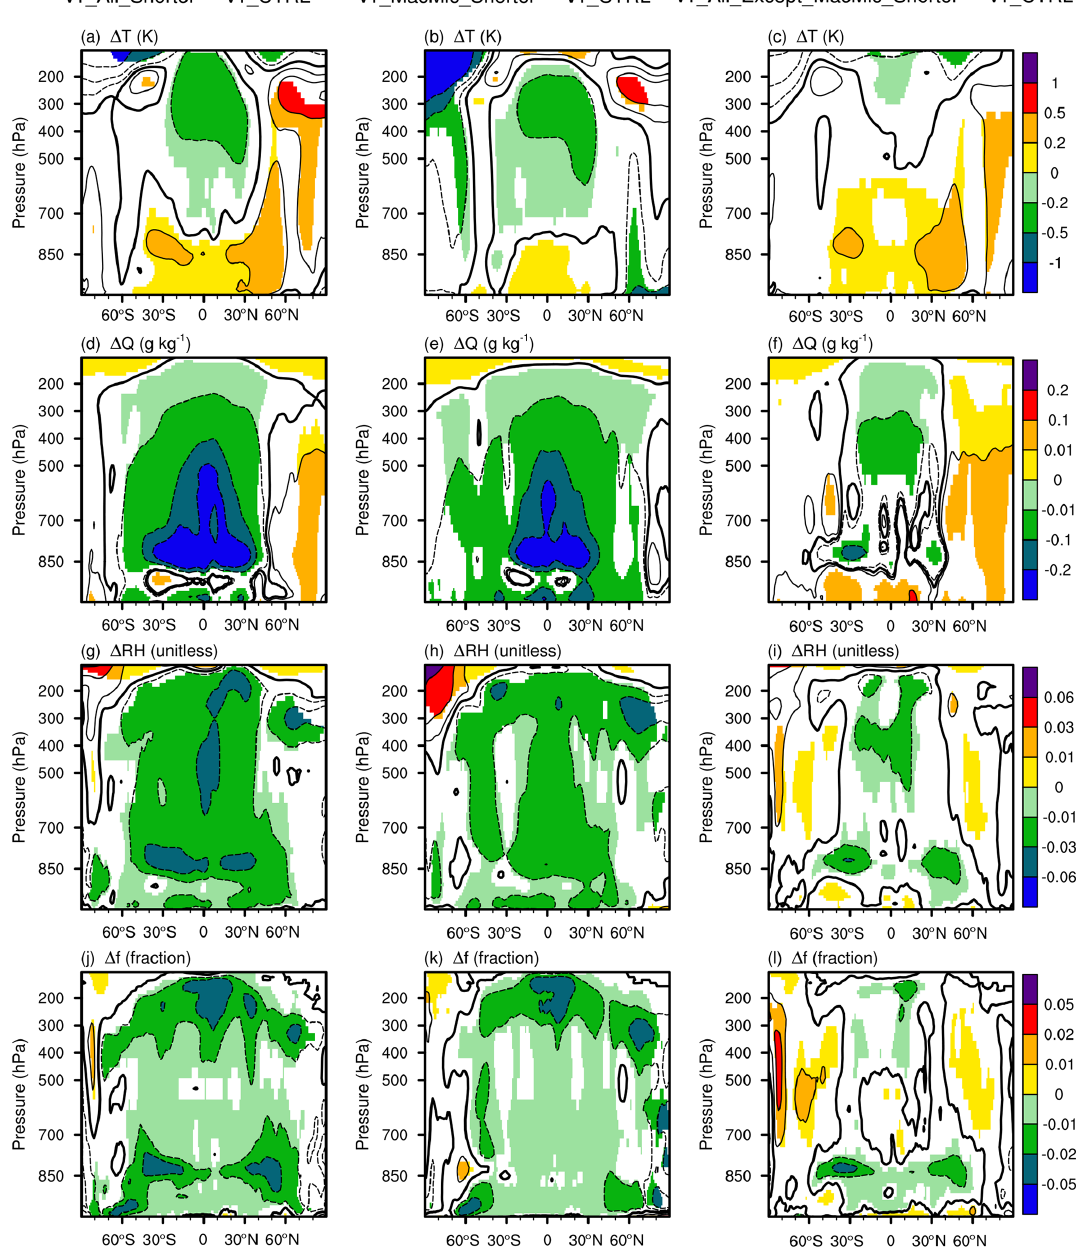
Figure 8. Differences in 10-year mean zonally averaged air temperature ( T ), specific humidity ( Q ), relative humidity (RH), and cloud fraction ( f ) between various simulations. Left column: v1_All_Shorter – v1_CTRL, revealing the impact of shortening all major time steps listed in Eqs. (1)–(4). Middle column: v1_MacMic_Shorter – v1_CTRL, revealing the impact of shortening time steps for the subcycled cloud macrophysics and microphysics parameterizations. Right column: v1_All_Except_MacMic_Shorter – v1_CTRL, revealing the impact of shortening step sizes outside the cloud macrophysics and microphysics subcycles. Statistically insignificant differences are masked out in white. The simulation setups are summarized in Tables 1 and A1. Schematics depicting the time integration loop and different step sizes can be found in Figs. 2 and